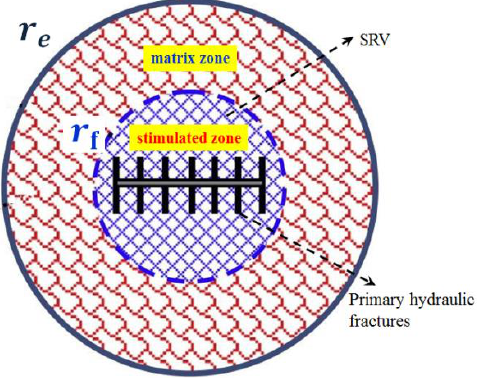
Figure 1 Physical model of fractured horizontal well in shale reservoir. Figure 1. Physical model of fractured horizontal well in shale